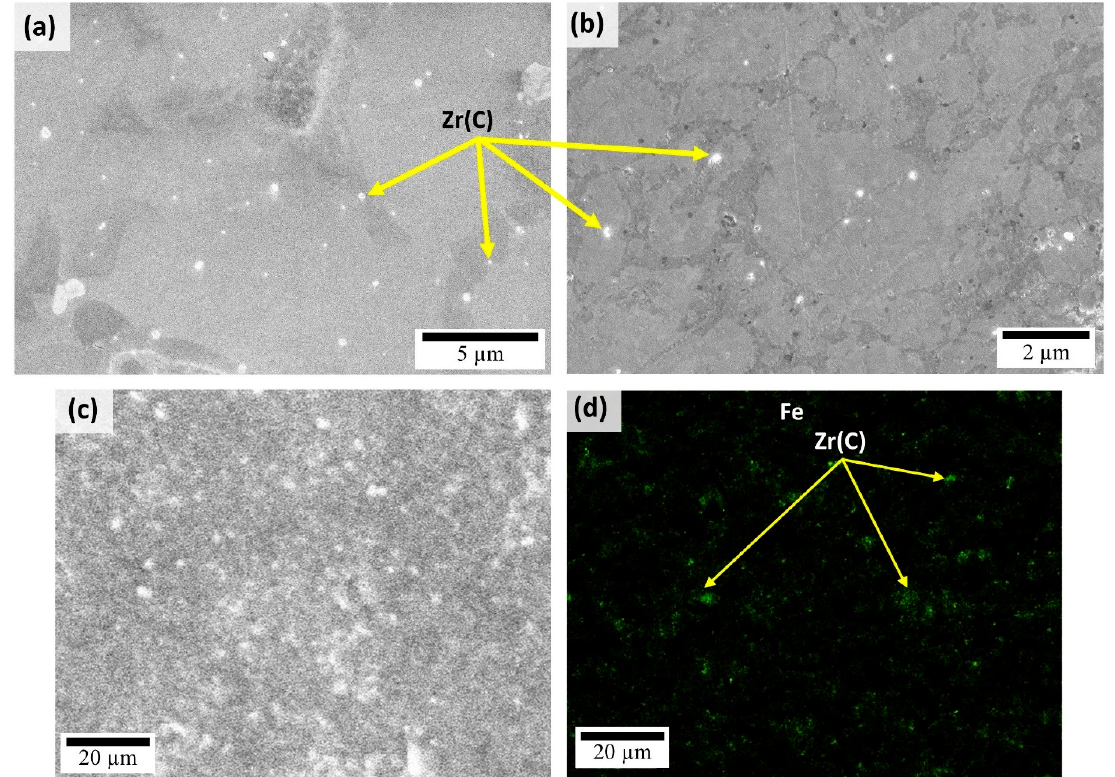
Figure 8. Nanoparticle dispersion in the metal matrix ( a , b ) SEM secondary electron micrographs of the sintered Fe-5 vol.% ZrC powder samples, ( c ) SEM secondary image of a selected area of the sintered sample that was mechanically shaken for 1 h ( d ) EDS signal map of Zr elements of the area presented in ( c ) showing the distribution of NPs.